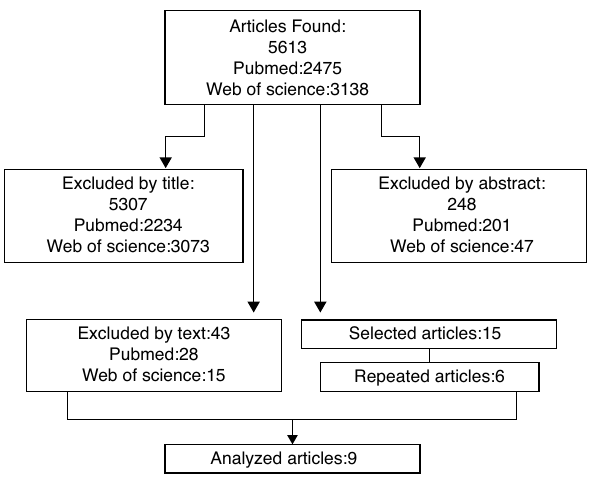
Figure 1 Flowchart of the number of articles found and selected after the application of inclusion and exclusion crite-